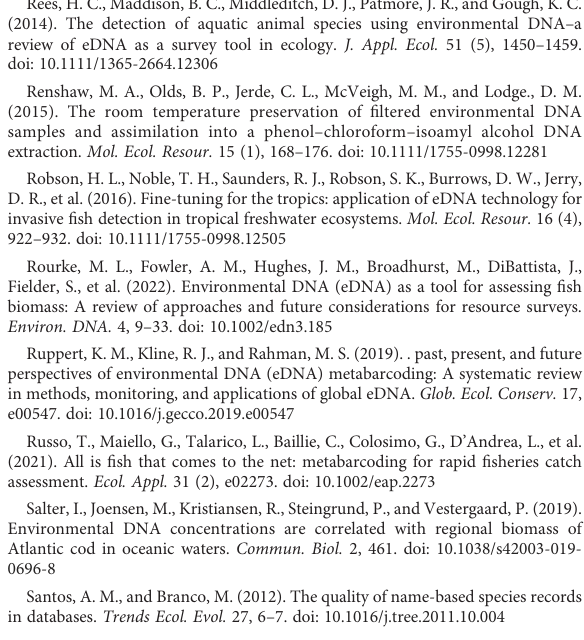
Taberlet, P., Prud ’ Homme, S. M., Campione, E., Roy, J. , Miquel, C., Shehzad, W., et al. (2012b). Soil sampling and isolation of extracellular DNA from large amount of starting material suitable for metabarcoding studies. Mol. Ecol. 21 (8), 1816 – 1820. doi: 10.1111/j.1365-294X.2011.05317.x Taberlet, P., Waits, L. P., and Luikart, G. (1999). Noninvasive genetic sampling: look before you leap. Trends Ecol. Evol. 14, 323 – 327. doi: